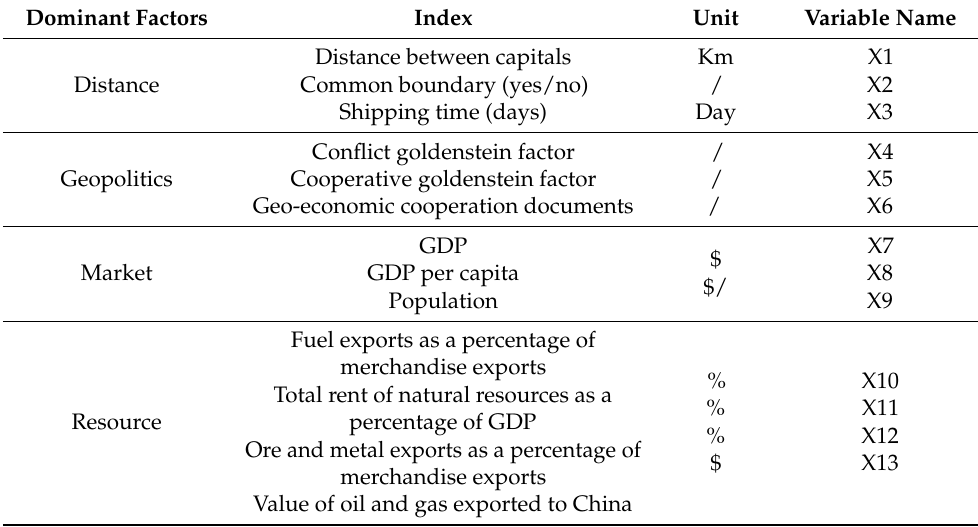
Table 3. Index system of geo-economic relation